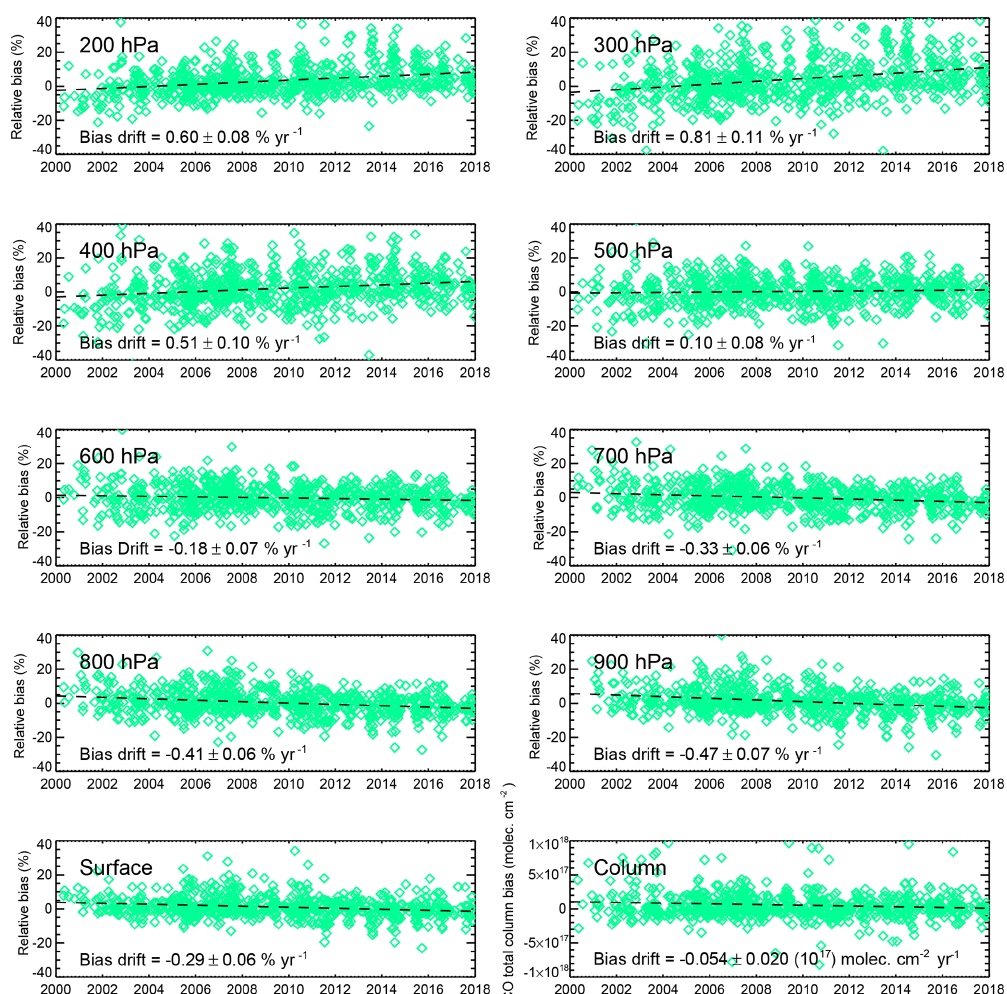
Figure 1. Retrieval bias drift for V7 TIR-only products based on the NOAA flask